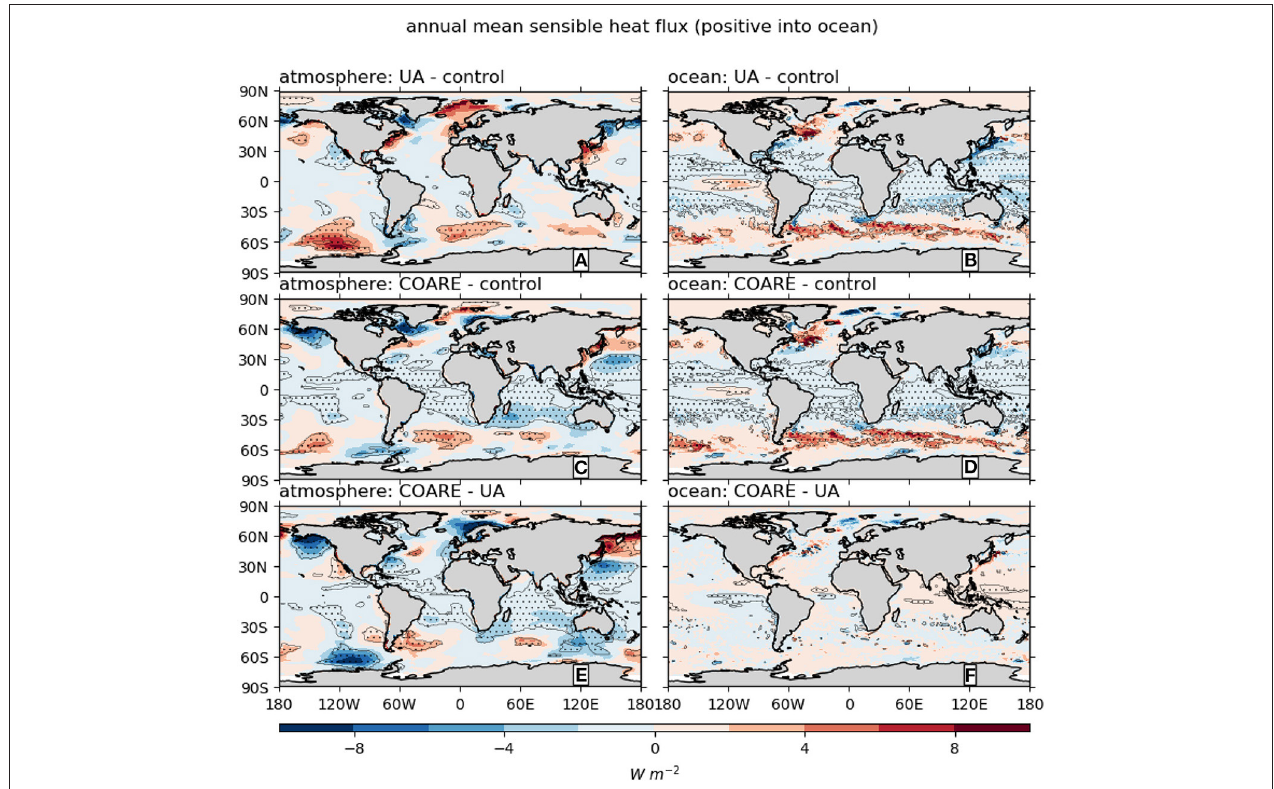
FIGURE 3 | Differences in annual mean sensible heat flux climatology between simulations with different bulk flux algorithms. The atmosphere and ocean simulation results are shown in left and right panels, respectively. Stippling designates regions where the absolute value of the difference is larger than the interannual standard deviation from the E3SMv1 pre-industrial control run. Note that the color scale is different from that in Figure 1 .